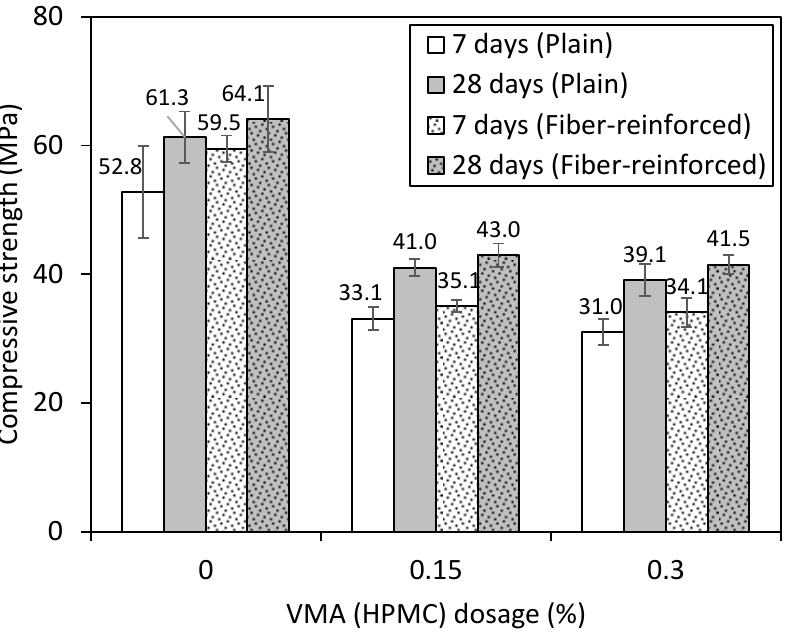
Figure 11. Compressive strength of the mold-cast specimens.